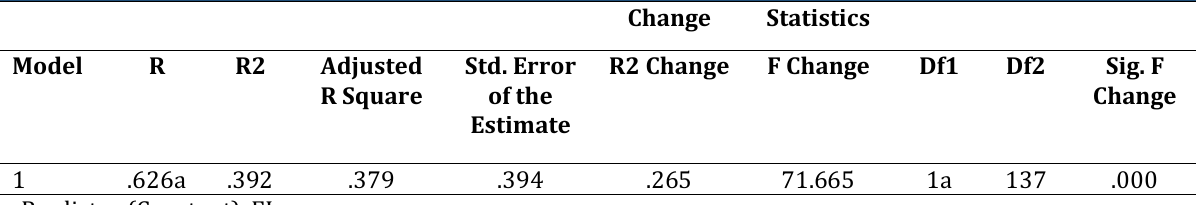
Table 4: Model summary for functional integration (FI)